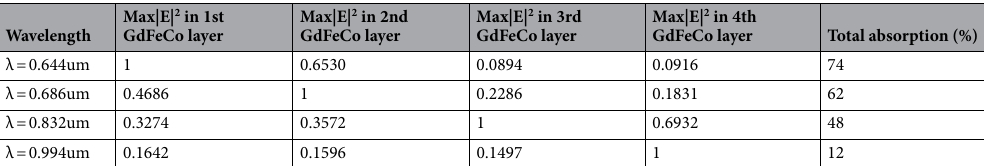
Table 3. The relative values of the maximum of |E| 2 in the magnetic layers at the operating wavelengths in the case of the patterned 9 nm-thick GdFeCo